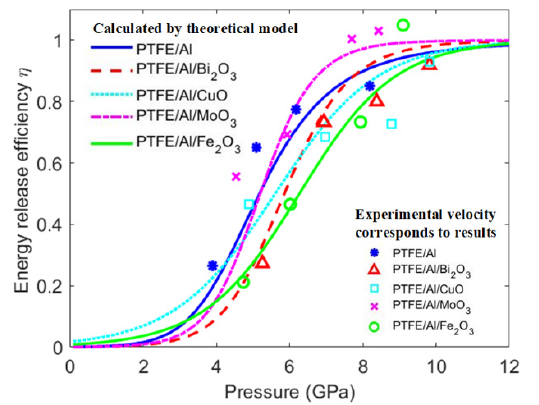
Figure 8. Energy release efficiency of PTFE/Al/oxide varying with impact pressure.